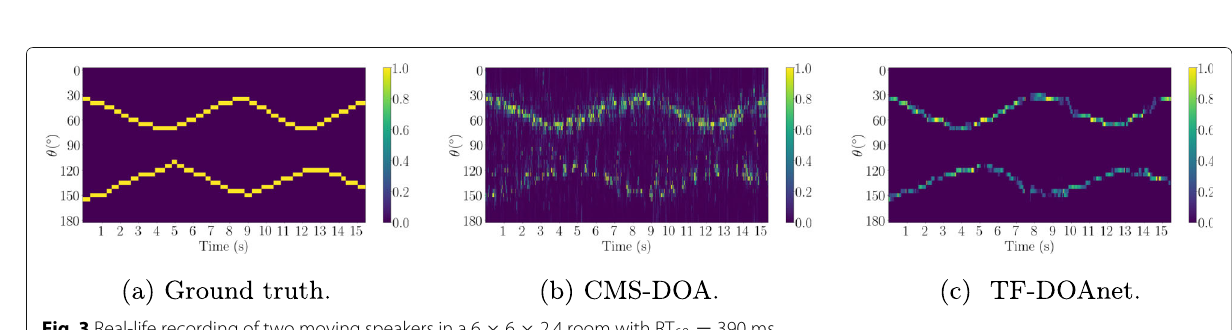
Fig. 3 Real-life recording of two moving speakers in a 6 × 6 × 2.4 room with RT 60 = 390 ms